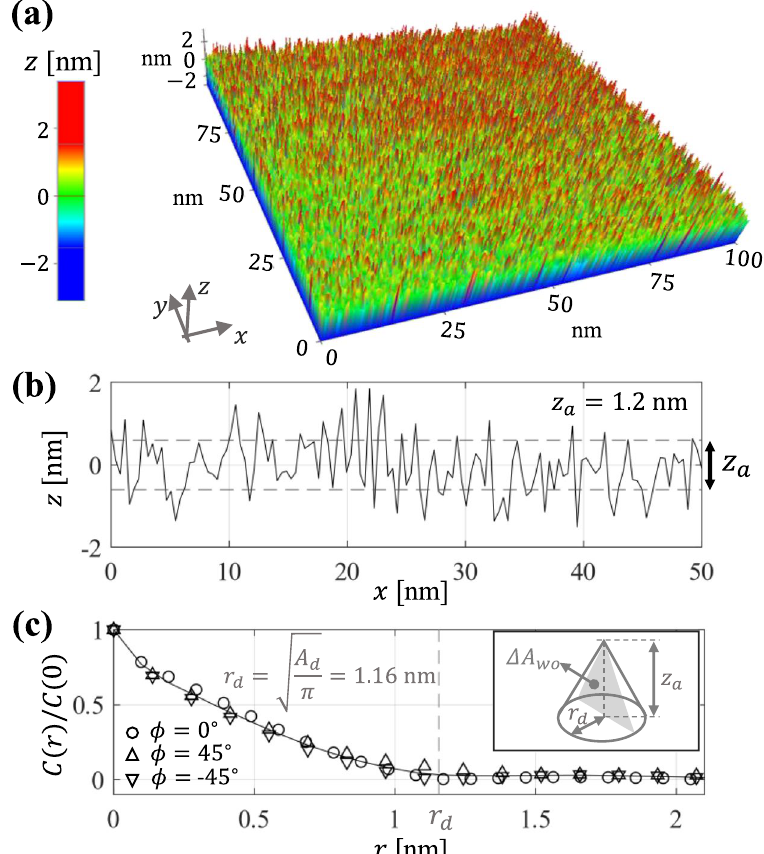
Figure 3. Nanoscale surface topography and model parameters. ( a ) 3D topographic image (512 × 512 pixels) of a borosilicate glass employed for spreading experiments obtained via NC-AFM. ( b ) 1D local height profile and = 1.2 nm. ( c ) Height autocorrelation function for different directions average height ∫ = | |   z z dx 2 / a 0 φ = atan( y / x ) = 0, ± 45 deg. Vertical dashed line indicates the correlation length π = r A / corresponding to d d averaged topographic “defects” with base area A d = 4.2 nm 2 . Inset illustrates a modeled conical “defect” with 2 , height z Δ A base area π = A r a , and cross-sectional area wo d d